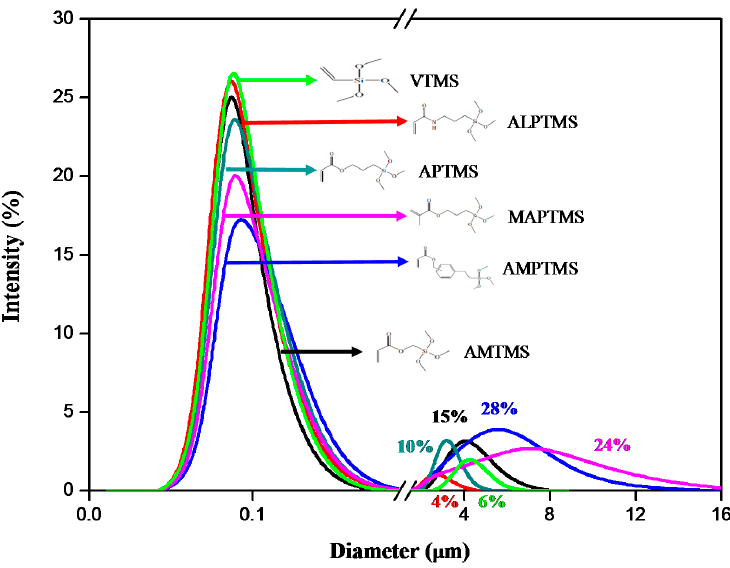
Figure 3. Particle size distribution curves of the SCA-coated Al 2 O 3 ceramic particles with different organofunctional groups. organofunctional